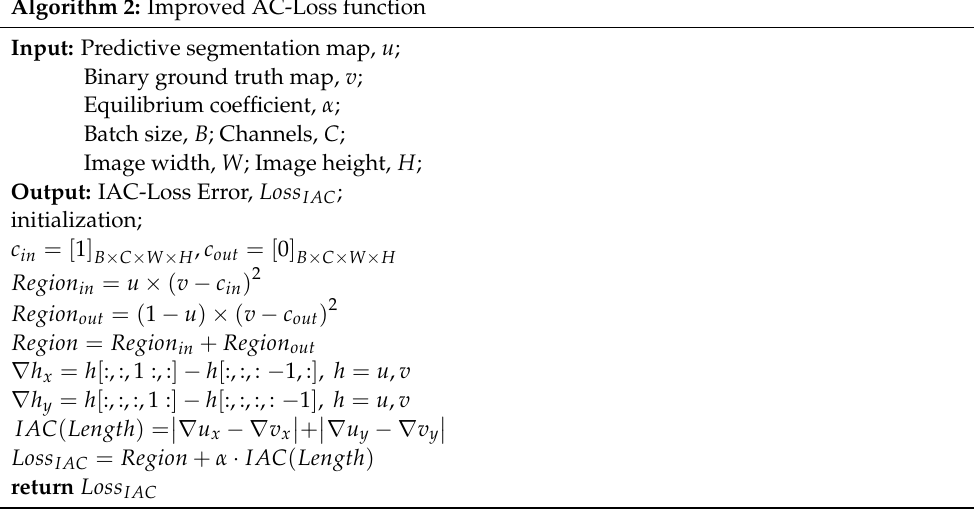
Algorithm 2: Improved AC-Loss